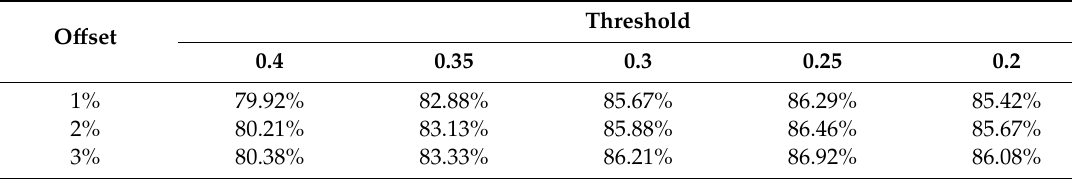
Table 4. Averaged detection probabilities of proposal 1 (window 2).